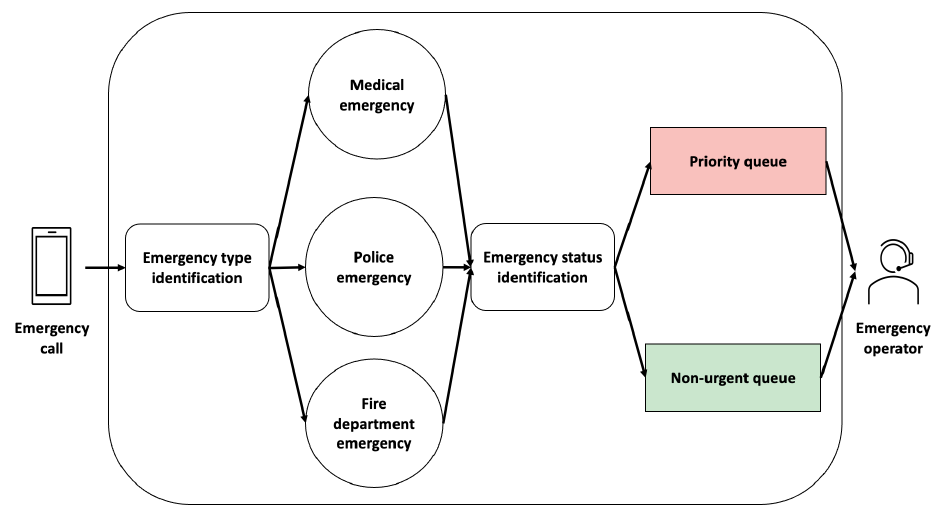
Figure 2. Chatbot/IVR solution business logic